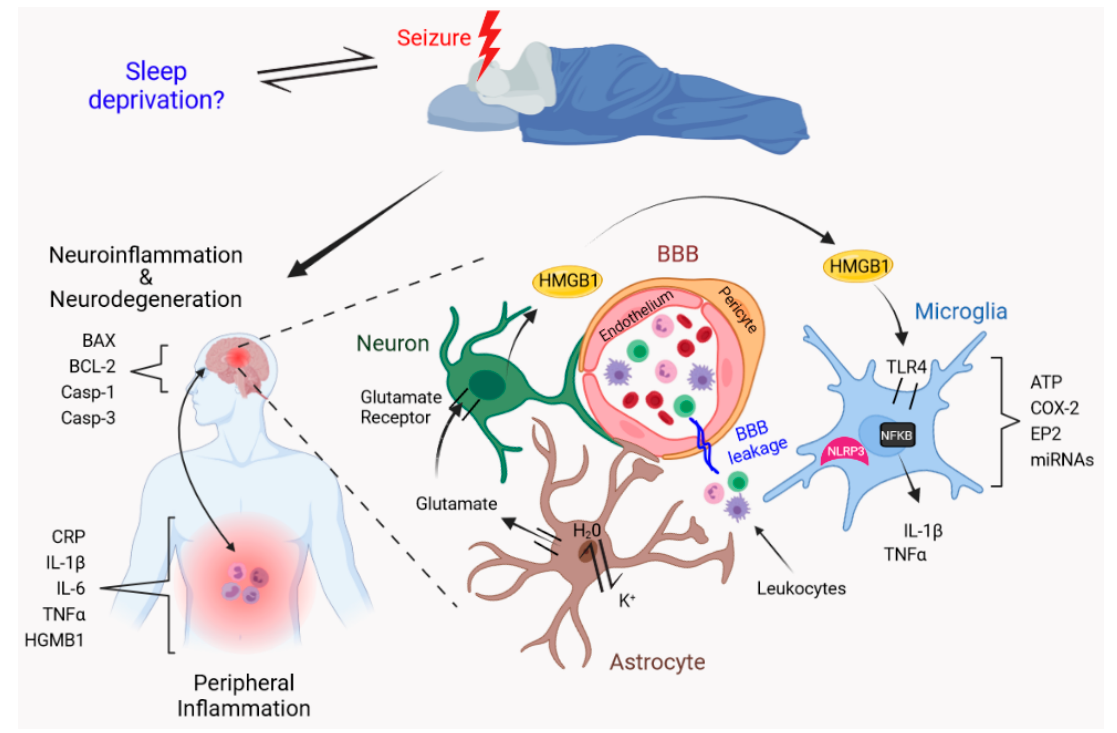
Figure 1. Proposed mechanisms of sleep disruption that contribute to neuroinflammation and worsen neurodegeneration in the epileptic brain. After seizures, peripheral and brain-resident immune cells become active, release danger signals, and produce pro-inflammatory mediators, including cytokines, complement factors, prostaglandins, among others, triggering a sustained vicious circle of neuroinflammation characterized by monocytic infiltration to the brain, astrocytic/microglial activation, and pro-inflammatory cytokine production, which ultimately leads to neurodegeneration. We propose that sleep disruption can act as a second inflammatory hit that increases seizure frequency and aggravates neuronal loss, thus favoring the progression of epilepsy. This figure was created with BioRender.com.